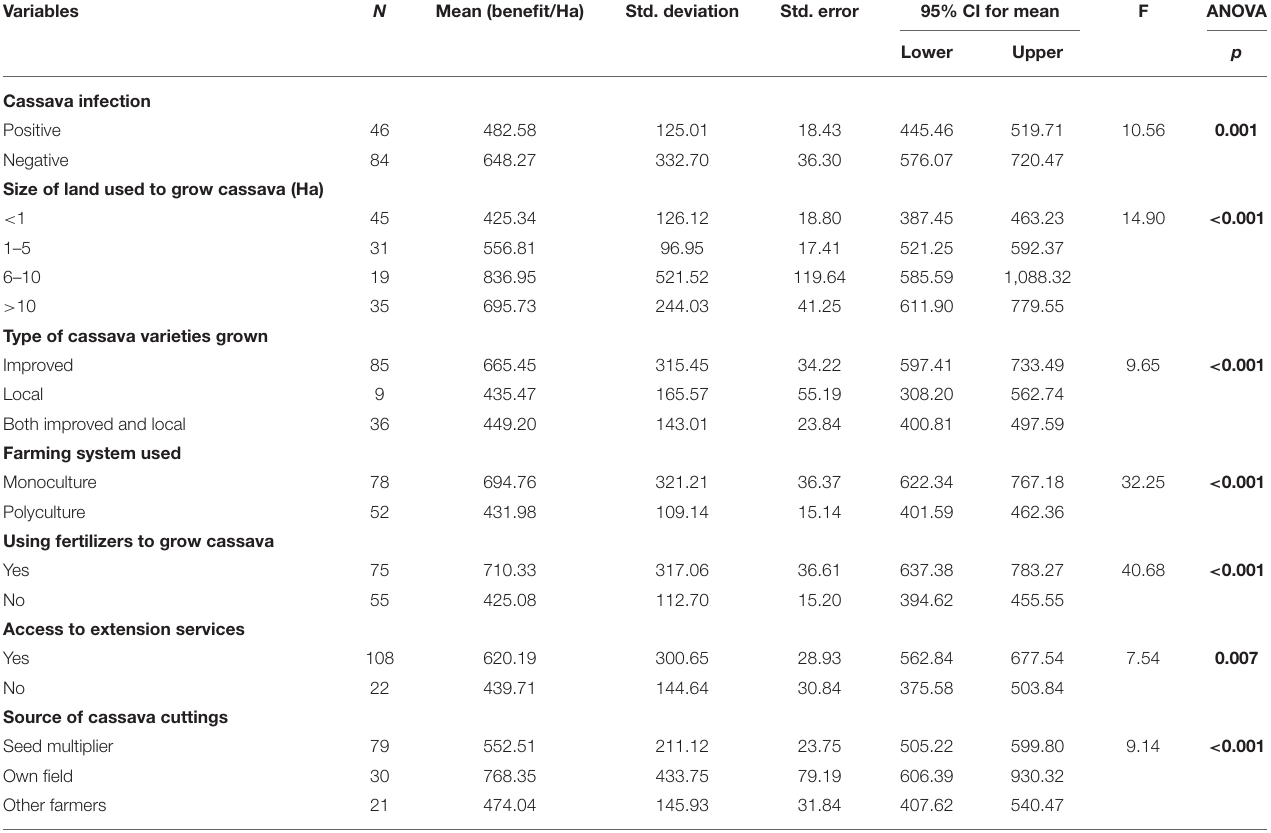
TABLE 5 | Effects of economic and agronomic variables on cassava productivity. Variables N Mean (benefit/Ha) Std. deviation Std. error 95% CI for mean ANOVA